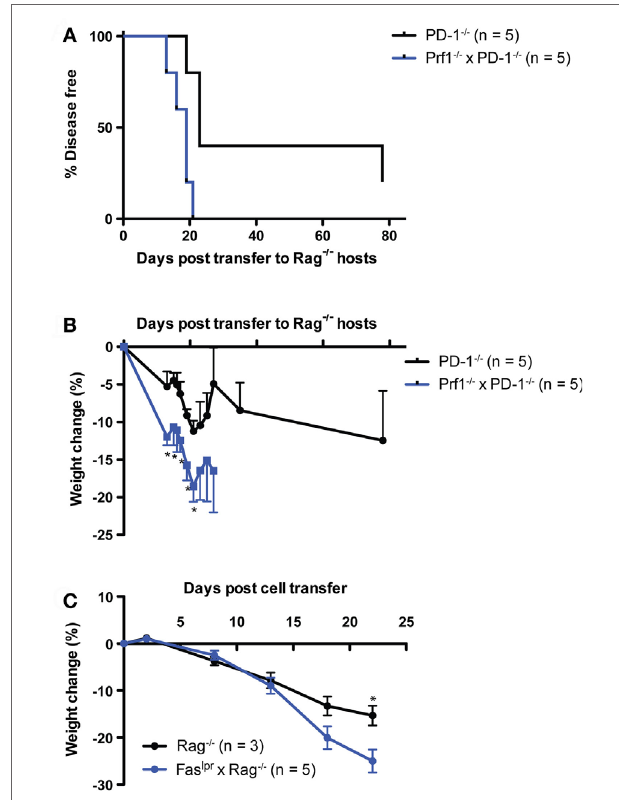
FigUre 4 | Systemic autoimmunity after PD-1 − / − thymocyte transfer to lymphopenic recipients is independent of both perforin and Fas-mediated killing. 10 × 10 6 Thymocytes from PD-1 − / − or Perforin − / − × PD-1 − / − (Prf1 − / − × PD-1 − / − ) animals were transferred i.v. to NK depleted adult Rag − / − recipients and mice were monitored for disease symptoms. (a) Kaplan–Meier survival curve analysis of disease incidence among individual recipients of the indicated thymocytes. Survival curve comparison demonstrated a significant difference between the two groups with p = 0.01. (B) Weight change among the recipients in (a) , ± SEM. Data are from one experiment, starting n values are indicated in the legend. (c) Splenocytes and inguinal lymph node cells were harvested from three diseased Prf1 − / − × PD-1 − / − thymocyte recipients from the experiment depicted in (a) at day 28 post-transfer, and 20 × 10 6 cells were transferred i.v. into NK depleted, adult Rag − / − or Fas lpr × Rag − / − recipients. One Fas lpr × Rag − /